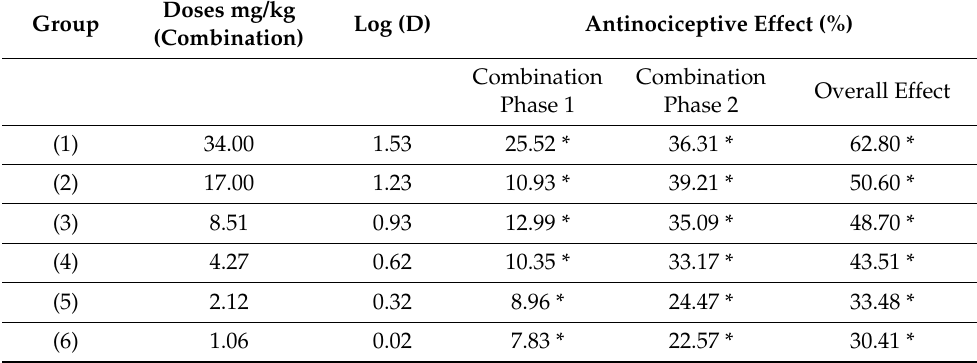
The antinociceptive effect, expressed in percentage, was obtained from the mean of the AUC of the number of paw flinches of each combination group ( n = 6) in the 2% formalin test. Drugs were ad- ministered intragastrically. * = Statistically significant difference versus vehicle group.